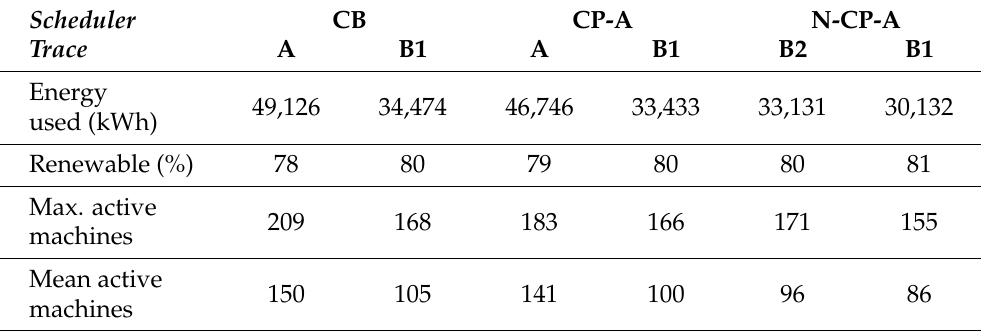
Table 3. Results from the workload schedulers, with different trace loads (500 machines). A: Unal- tered, B1: Custom, B2: Custom predicted.